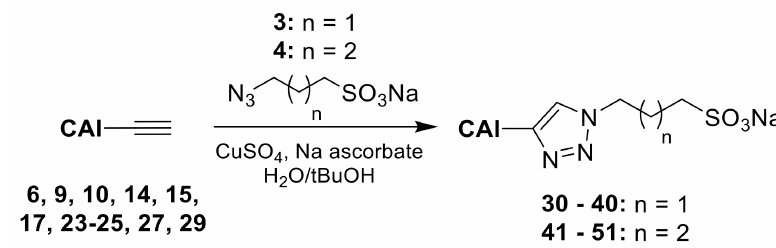
Scheme 3. Huisgen azide-alkyne 1,3-dipolar cycloaddition to afford 1,2,3-triazoles 30 – 51